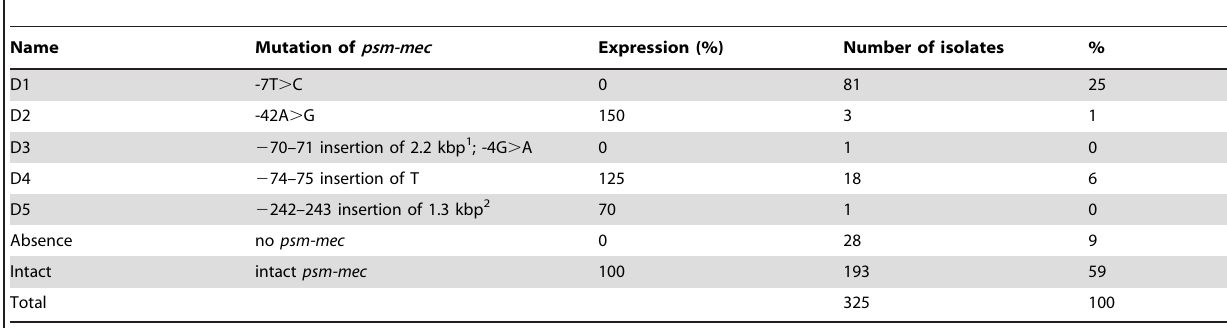
Table 1. Identification of mutations of the psm-mec gene from MRSA